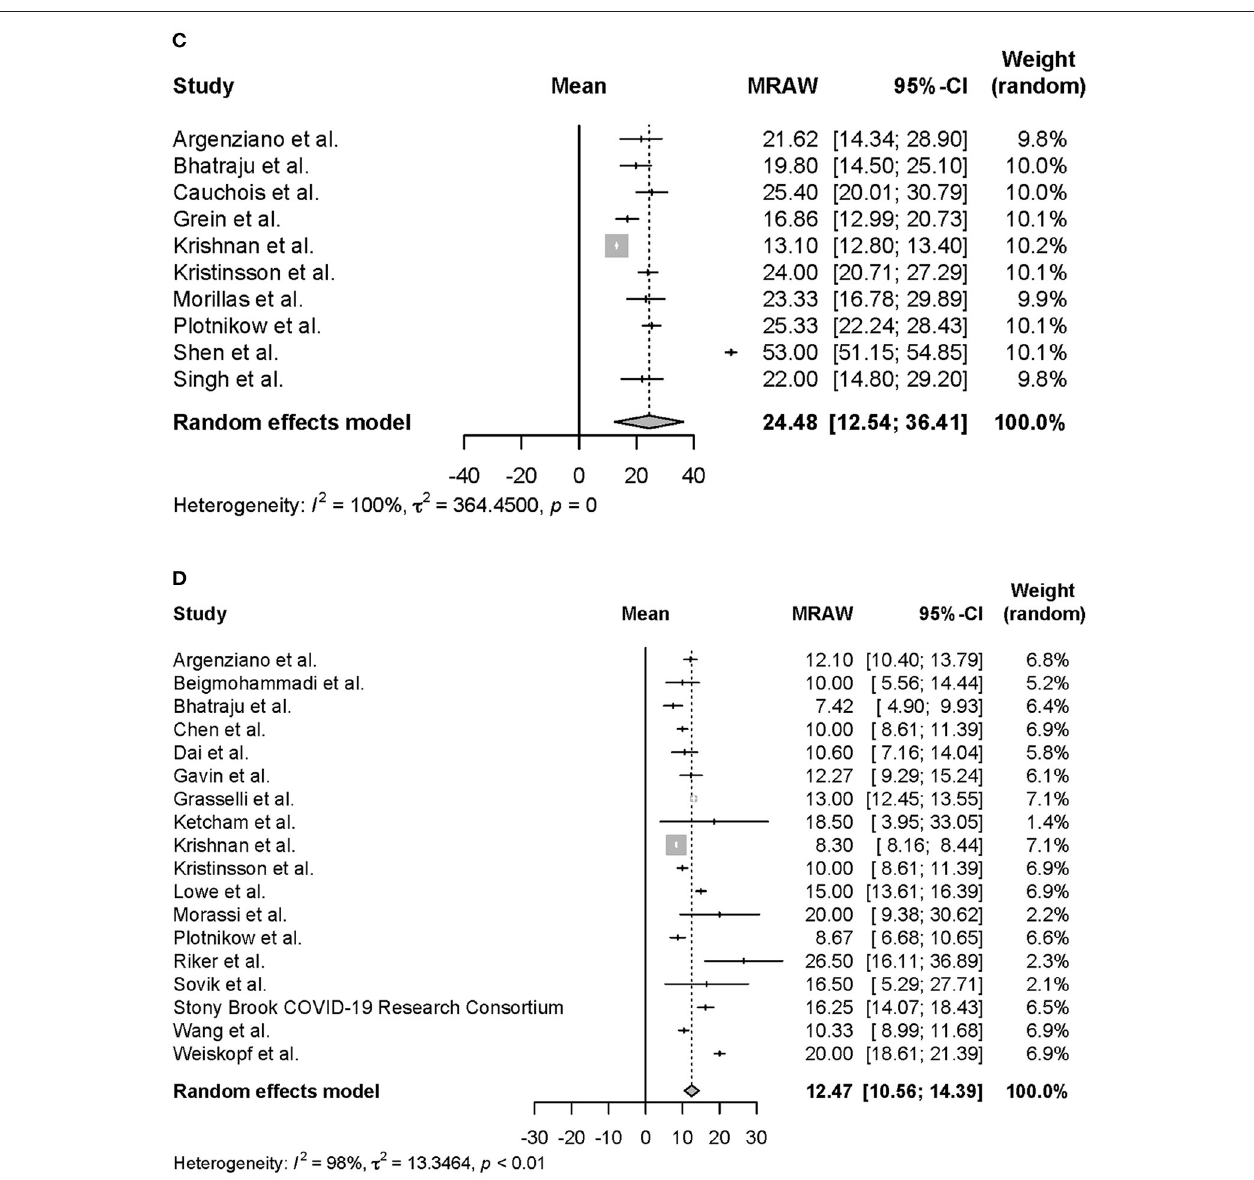
FIGURE 4 | Forrest plot: a meta-analysis of the time from hospitalization onset to each clinical endpoint in intubated COVID-19 patients. The hospitalization-intubation period of intubated survivors (A) , the hospitalization-intubation period of intubated non-survivors (B) , the hospitalization-discharge period of intubated survivors (C) , and the hospitalization-death period of intubated non-survivors (D) were calculated using the random effects model. MRAW, the raw data of mean; 95% CI, 95% confidence interval.